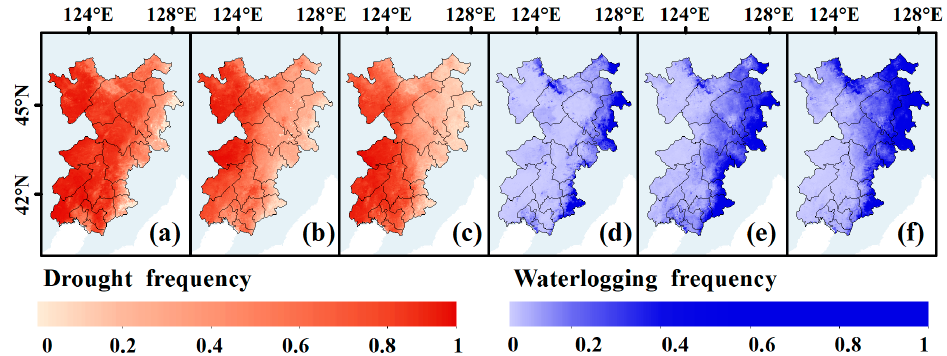
Figure 8. Frequency of drought and waterlogging in the three growth stages in Songliao Plain: ( a , d ) the early growth stage; ( b , e ) the mid-growth stage; and ( c , f ) the late growth stage.